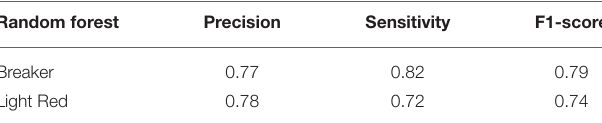
TABLE 2 | Precision, Sensitivity, and F1-score of the Random Forest model to Breaker and Light Red